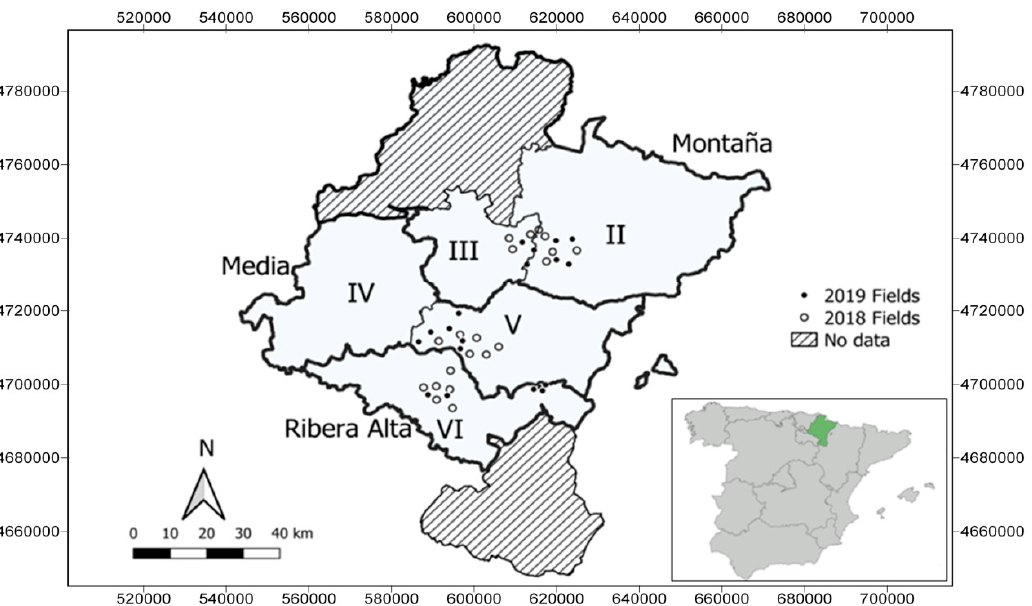
Figure 1. In the bottom right corner is shown a map of Spain with Navarre highlighted in green. On the main map the fields of study are point-marked in white for the seasons 2018 and in black for 2019. The three Navarre’s sub-regions: the northern (Montaña), the middle (Media), and the Southern (Ribera Alta) are also indicated. The agrarian zones are indicated with roman numerals: in Montaña zones II and III, in Media zones V and IV, and in Ribera Alta zone VI. UTM (Universal Transverse Mercator) coordinates are expressed in meters.